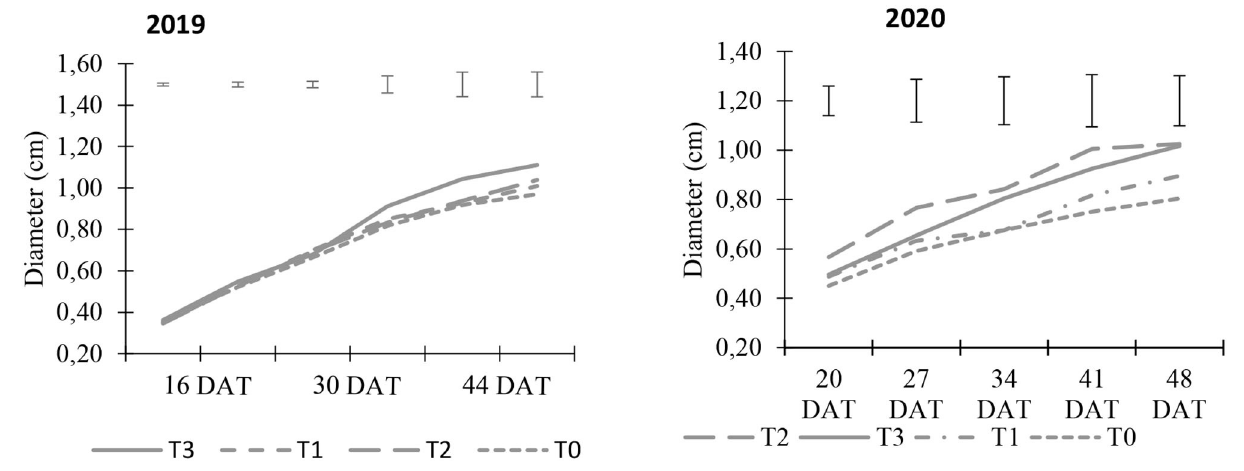
FIGURE 1 | Weekly tomato plant diameter days after transplanting